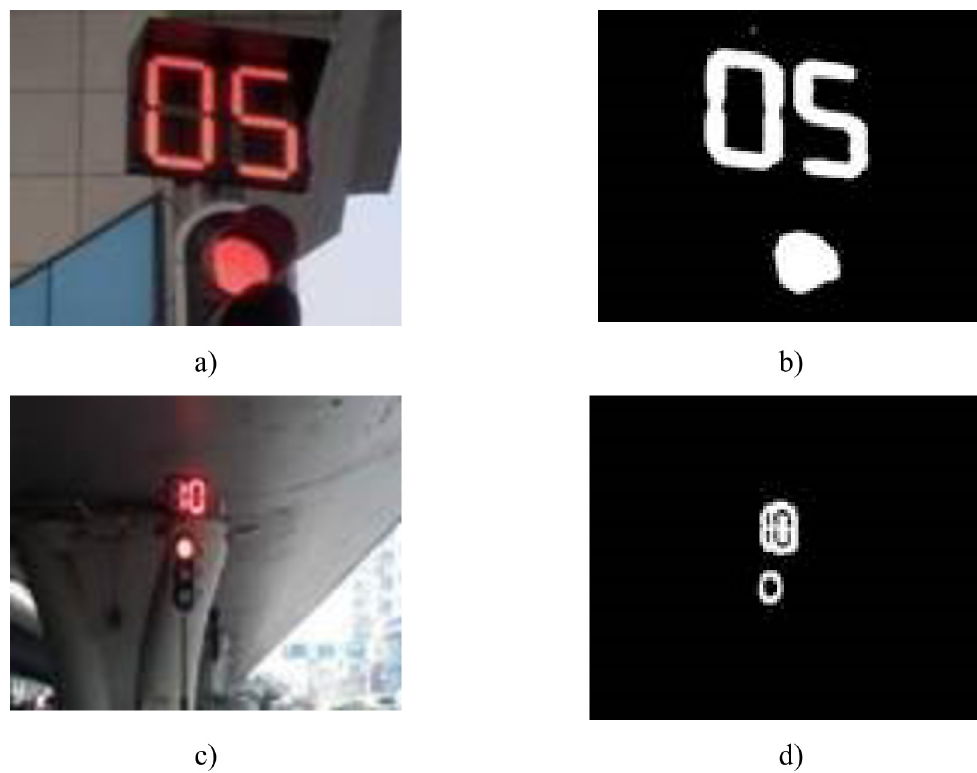
Fig 5. The comparison images before and after traffic lights color